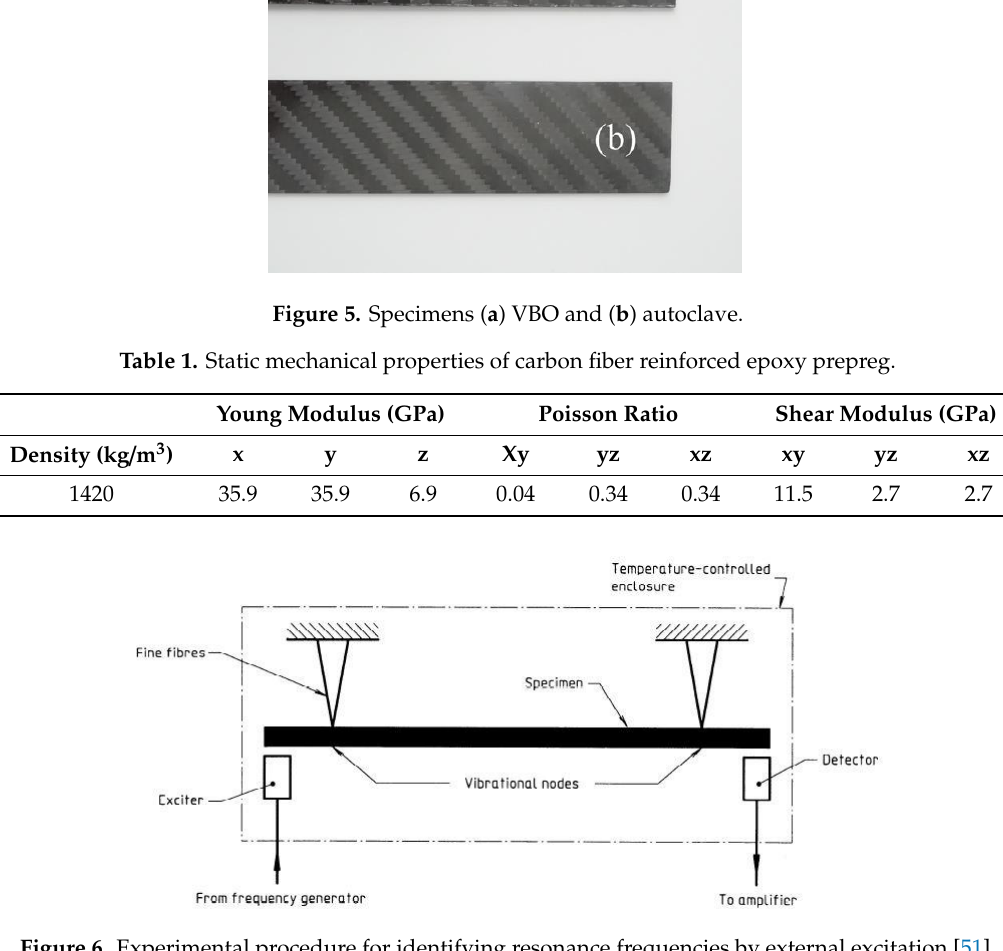
Figure 5. Specimens ( a ) VBO and ( b ) autoclave.